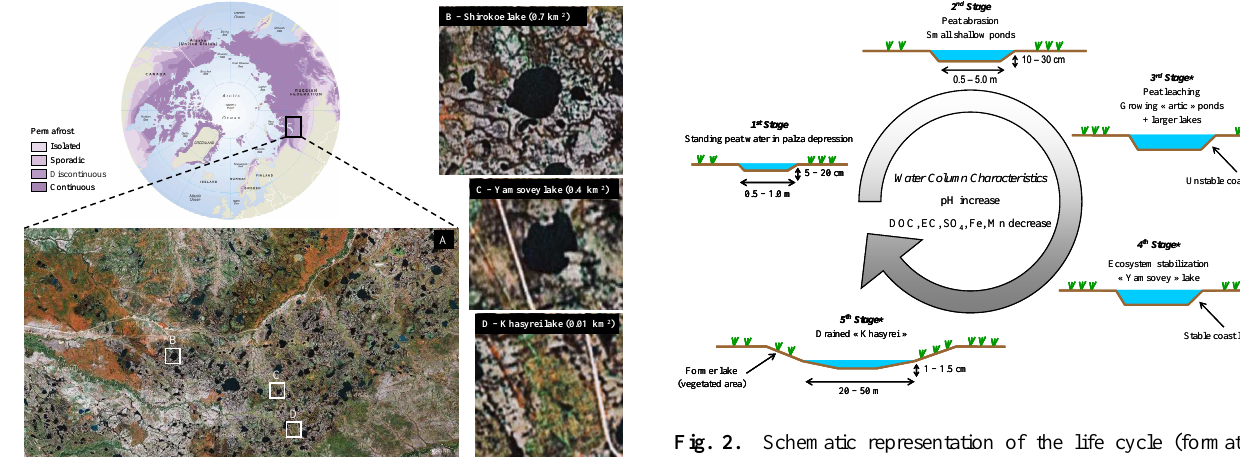
Figure 2 Audry et al. Fig. 2. Schematic representation of the life cycle (formation- expansion-drainage) of thermokarst lakes in the studied region. *Stages sampled in this study. POC, particulate organic carbon; EC, electrical